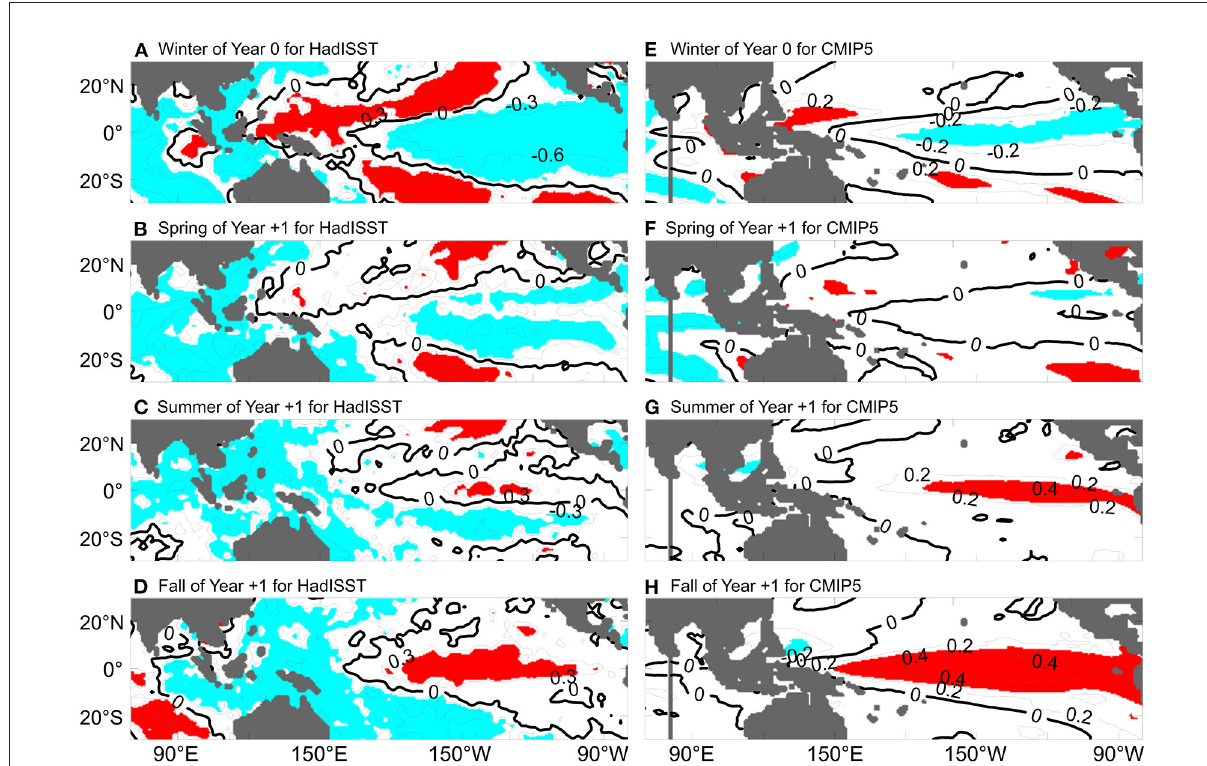
FIGURE3 Lag correlations between the STIO SSTA in the fall of Year 0 and the tropical Indo-Pacific SSTA from the winter of Year 0 through the fall of Year + 1. (A–D) HadISST; (E–H) cross-model averaged from CMIP5 historical simulations. The red and blue shading indicate the 95% significance level of positive and negative correlations,